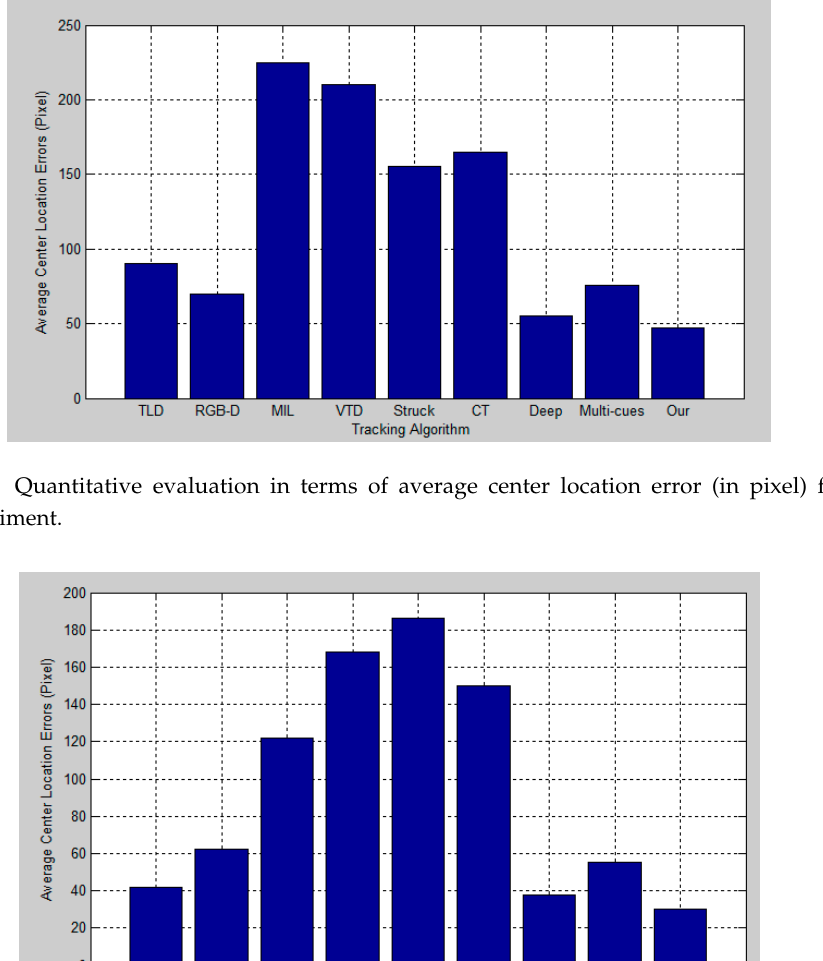
Figure 13. Quantitative evaluation in terms of average center location error (in pixel) for the second experiment.